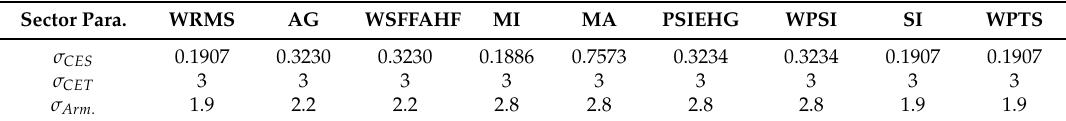
Table 2. The elasticity value of substitution of each sector. Sector